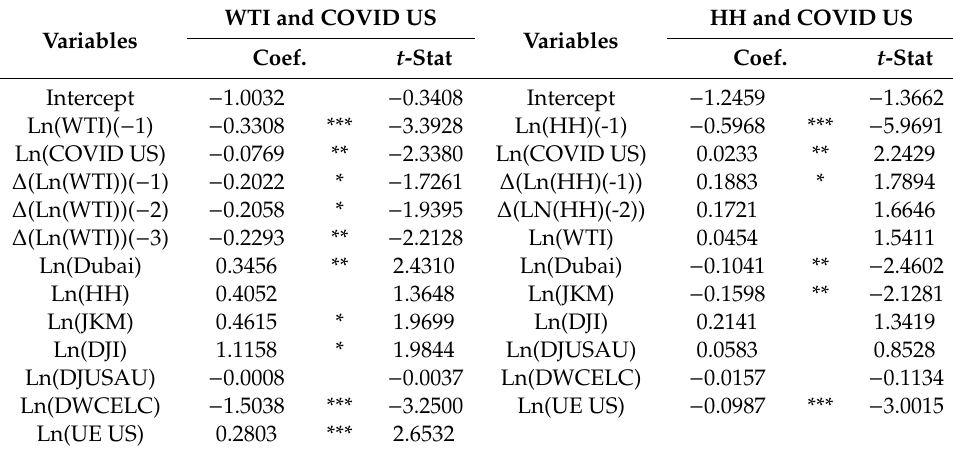
Table 8. Conditional error correction ARDL